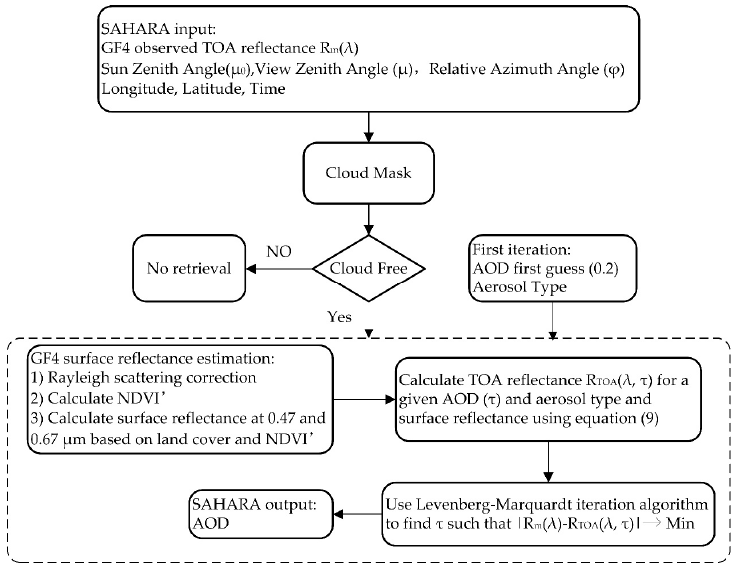
Figure 9. Flowchart of SAHARA algorithm.